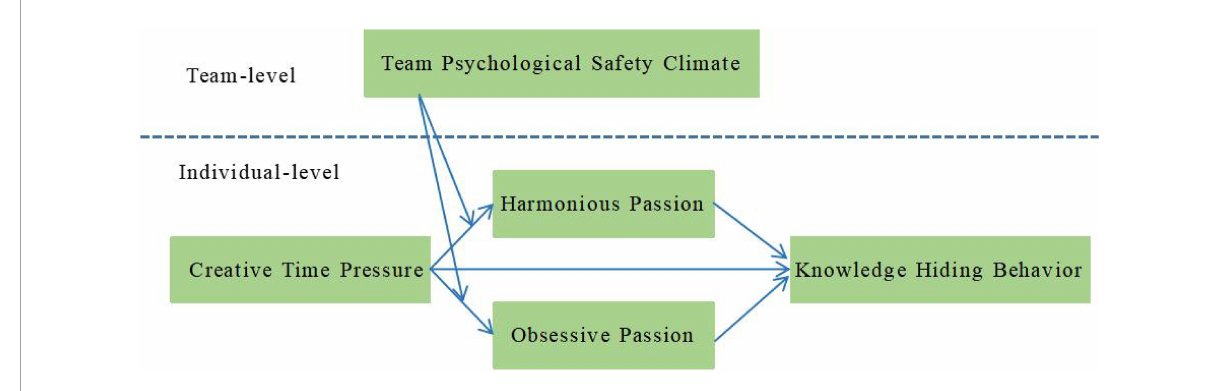
FIGURE1 Theoretical framework.